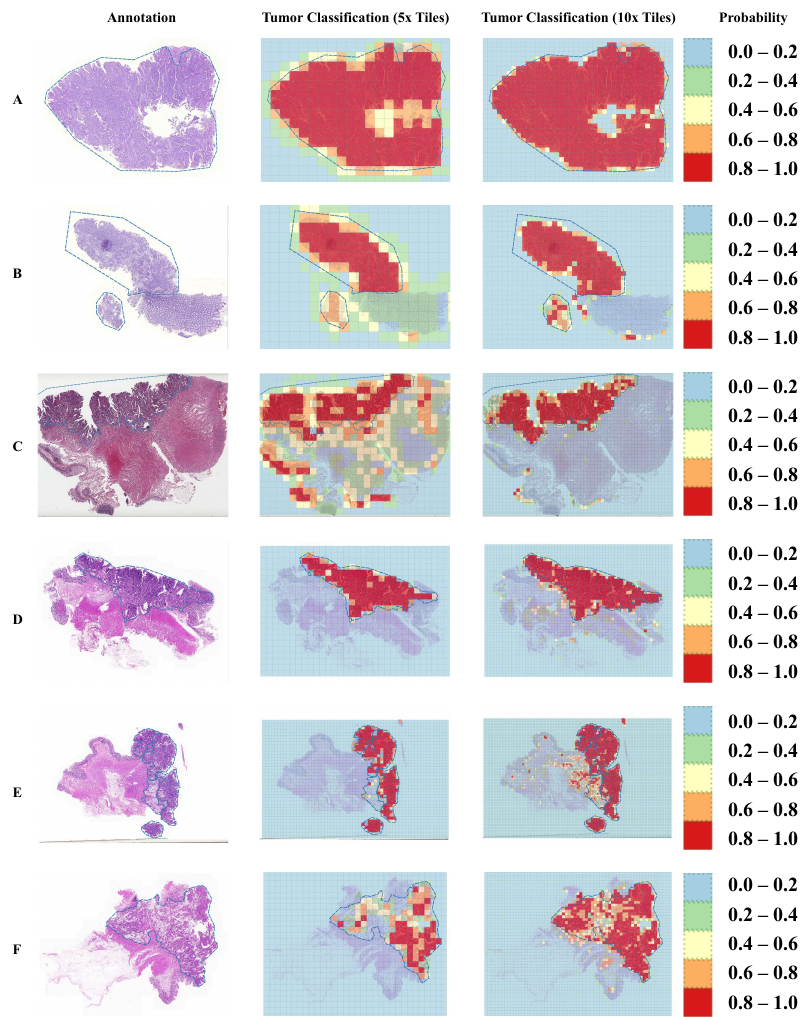
Figure 3. Probability maps of tumor classification using 5 × and 10 × tiles of the whole slide images (WSIs). The annotations created by the pathologist are marked with the blue dashed curve. The probability values are categorized into five groups with different color representations. The ( A – C ) and ( D – F ) samples are randomly selected from the testing set of TCGA-COAD and SYSU8H,